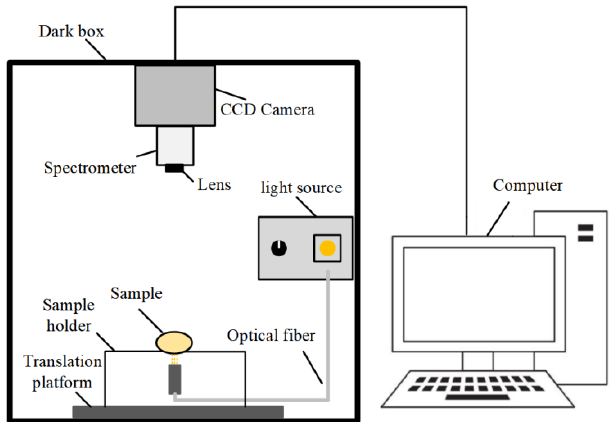
Figure 1. Hyperspectral imaging system.